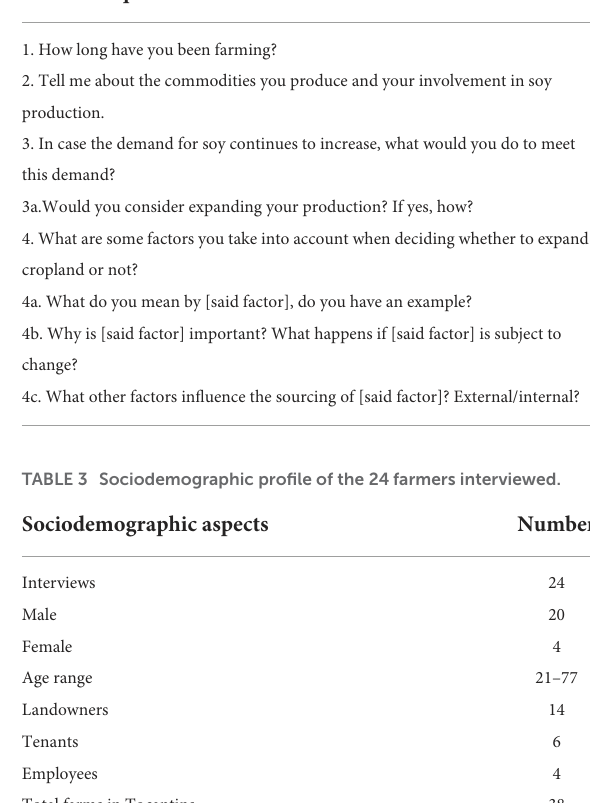
TABLE 2 Open-ended questions asked during the semi-structured interviews.